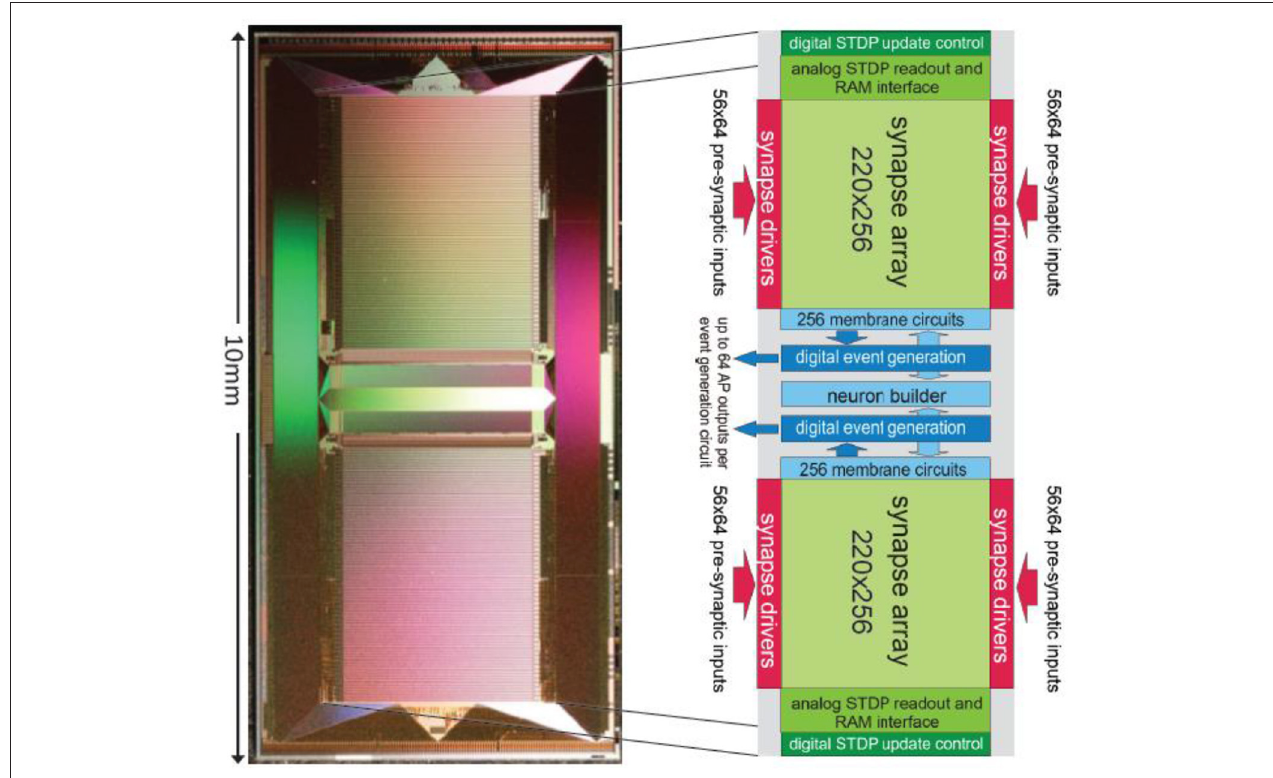
FIGURE 9 | Photograph of a single HICANN die. The enlargement shows a block diagram of the analog network core located in the center of the die.